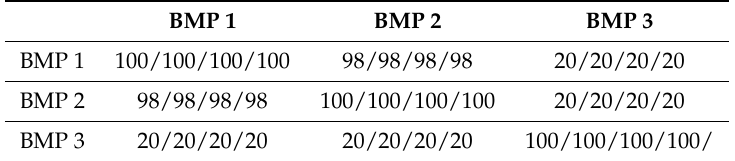
Table 16. Test results for similar BMP images with SiSe (hash vs. hash/file vs. hash/hash vs. file/file vs. file).